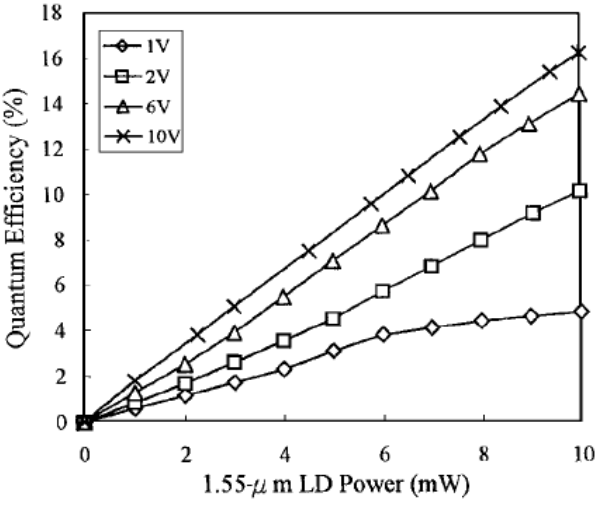
Figure 16. Photoconductive gain versus illumination power of a 1.55-µm laser diode with the bias voltage as a parameter for the photodetector proposed by Lee et al. [71] in 2001. Copyright © 2001 Optical Society of America.